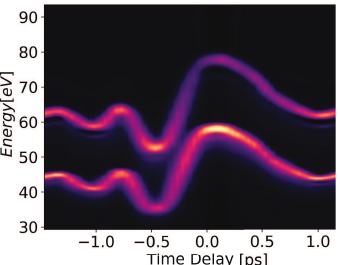
Figure 9. The plot shows the vector potential of the THz streaking field recorded in a delay scan. The THz pulses were temporally scanned with respect to the XUV pulses. For each delay, 30 photoelectron spectra were recorded. For the pulse duration analysis, the spectra in the middle of the linear slope (delay − 0.2 ps) were used. One can also see the broadening of the spectral lines with respect to the larger delays (with very low THz field), containing the information about the pulse duration.